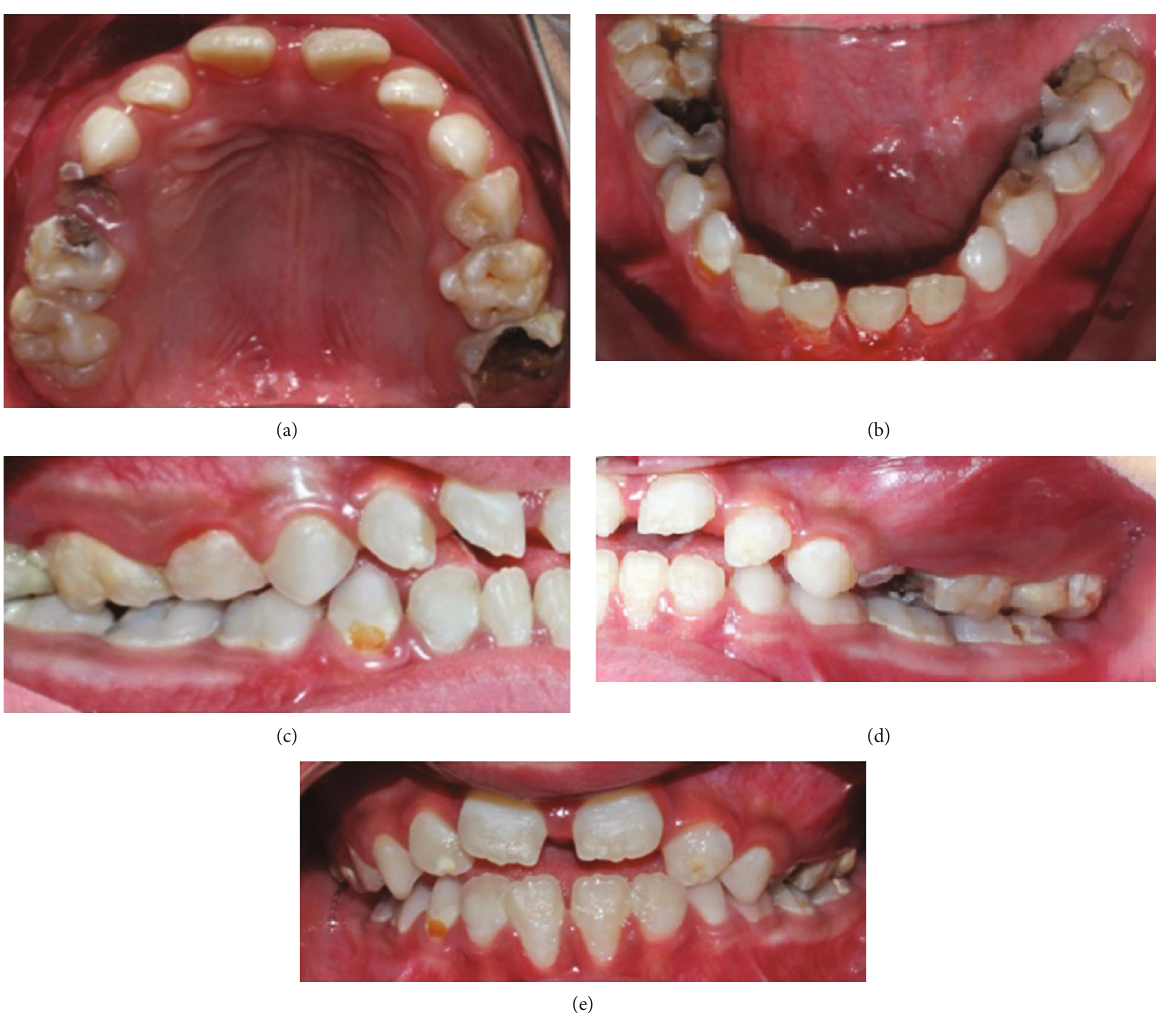
Figure 1: Intraoral preoperative photographs showing (a) maxillary occlusal view. (b) Mandibular occlusal view. (c) Right lateral view. (d) Left lateral view. (e) Frontal